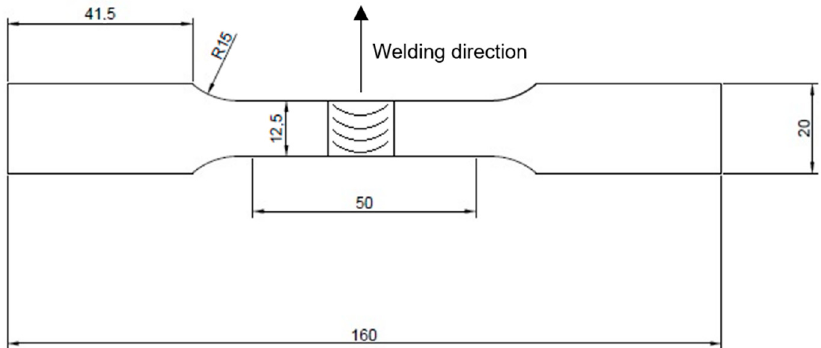
Figure 1. Scheme of sample for tensile testing. All dimensions are in mm.